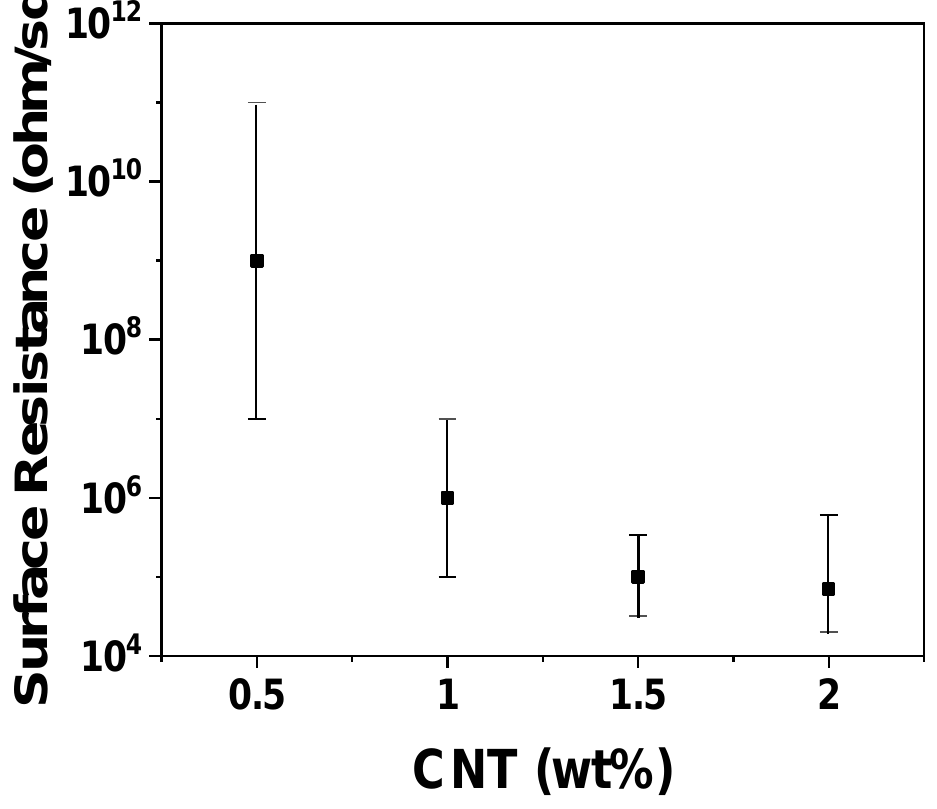
Figure 1. Surface resistance of POM/CNT composites as a function of CNT loading.